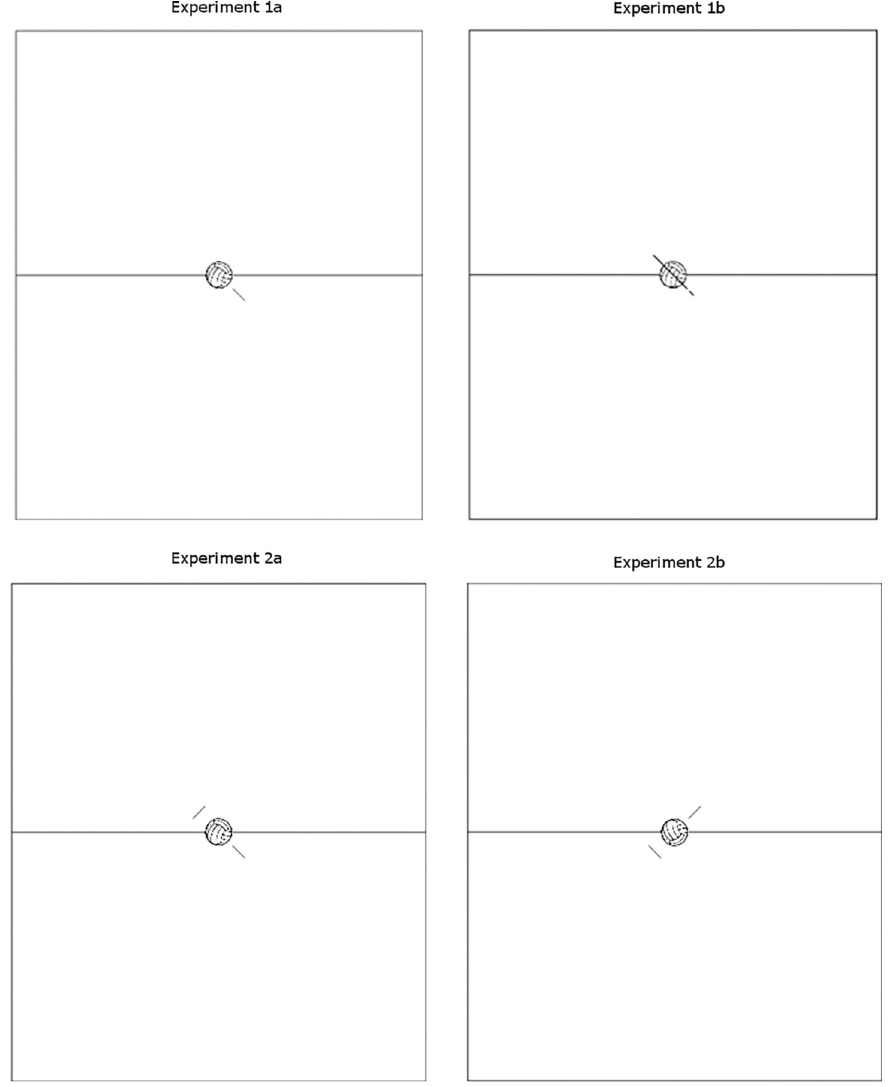
Fig 1. A schematic representation of the stimuli used across the four experiments (Top-left Panel = Experiment 1a; Top-right Panel = Experiment 1b; Bottom-left Panel = Experiment 2a; Bottom-right Panel = Experiment 2b). Note that only the condition with the right trajectory of the ball is reported. Elements in the present figure are not drawn to